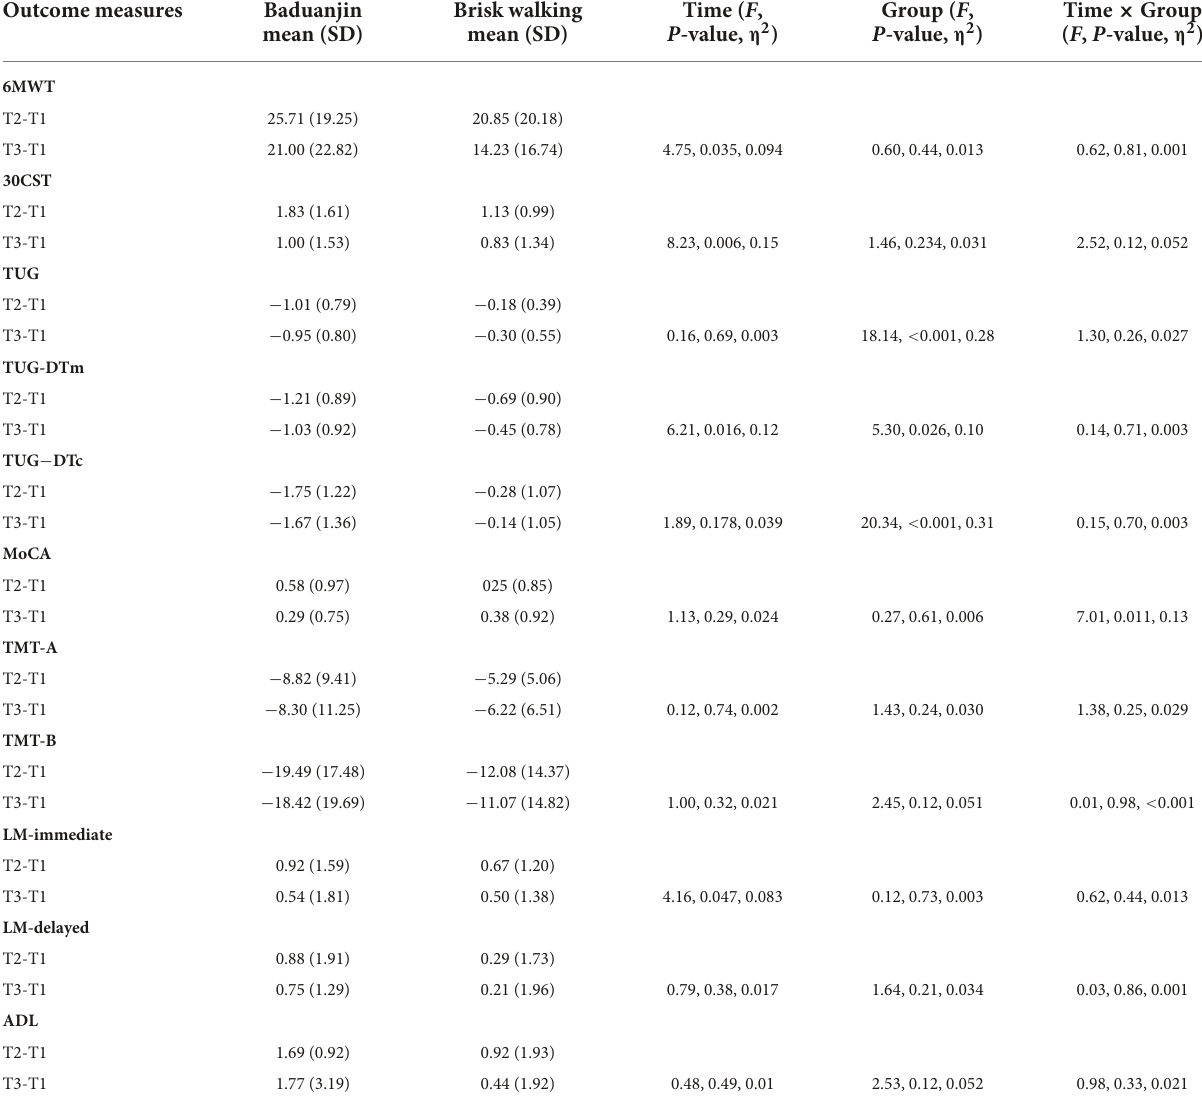
TABLE 2 Change scores of the outcome measures. Outcome